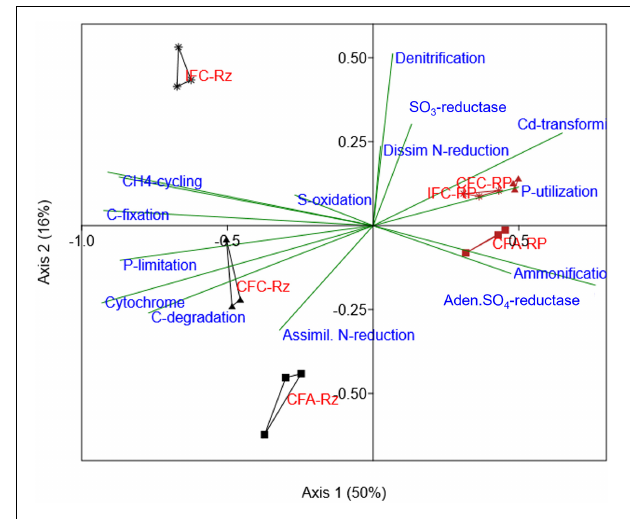
FIGURE 3 | Canonical correspondence analysis for ARB ( arsC gene) abundances compared with other functional associations (projected as bi-plot vectors) in their genomes (other gene category probes detected in these organisms). The arsC positive organisms from each sample were selected from other gene categories and their abundance was summed by samples. This data was used as variables for correspondence analysis and then were plotted according to their correlations with arsC gene probes. Suffix RP and Rz in group labels represent the root-plaque and the rhizosphere samples, respectively. CFA, continuously flooded-arsenic (squares); CFC, continuously flooded-control (triangles); IFC, intermittently flooded control (stars).